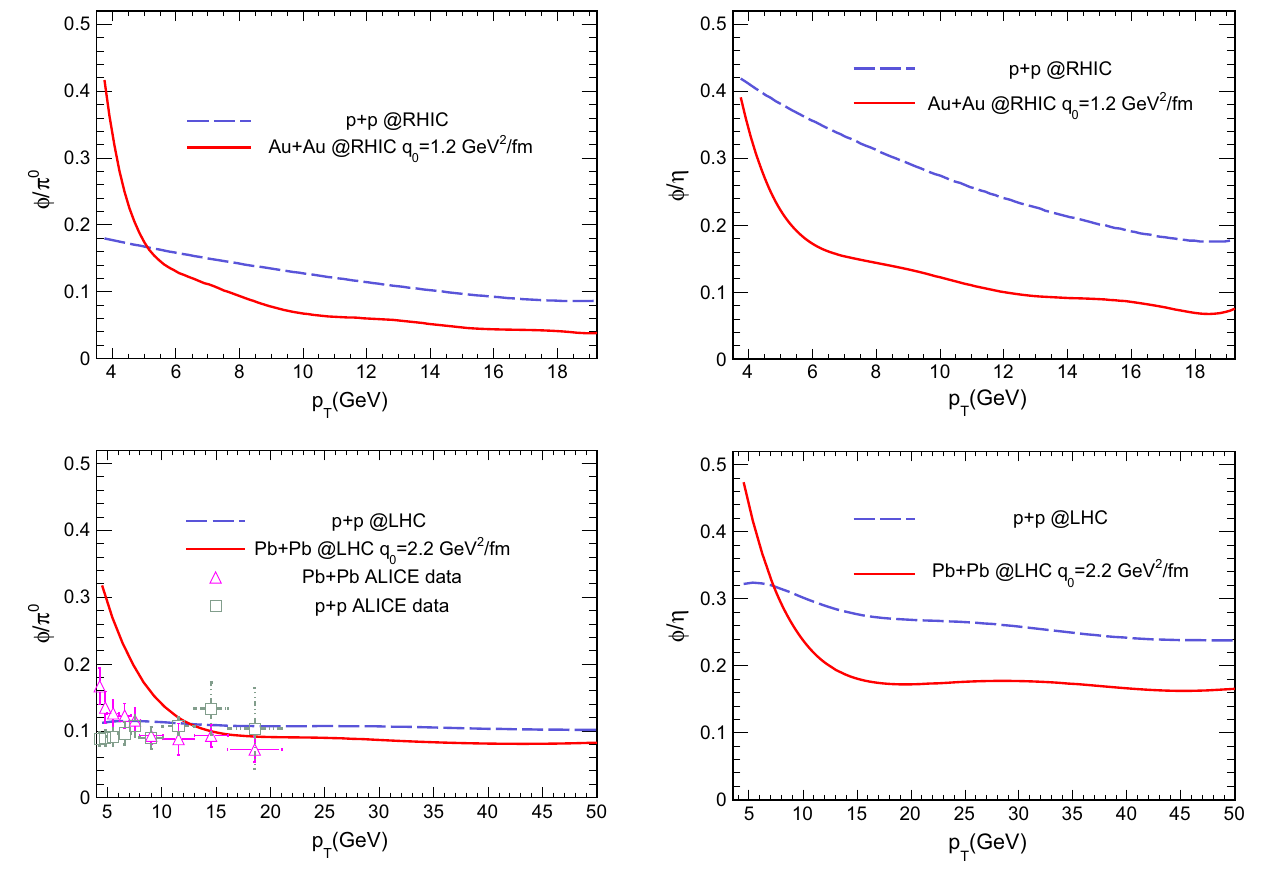
Fig. 7 Top Yield ratio φ/η as a function of p T in p + p and Au + Au collisions at the at the RHIC. Bottom φ/η as a function of p T in p + p and Pb + Pb collisions at the